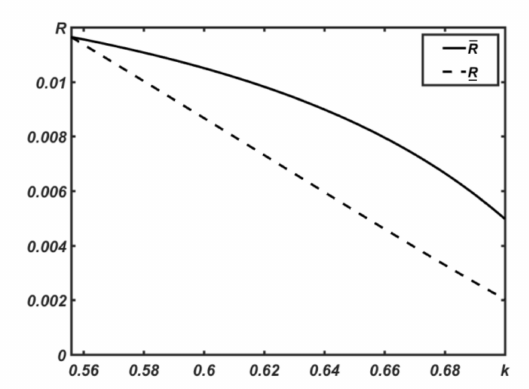
Figure 8. The revenue-sharing contract.